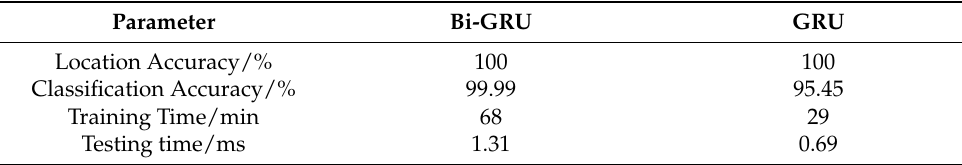
Table 9. The results comparison of GRU with Bi-GRU.